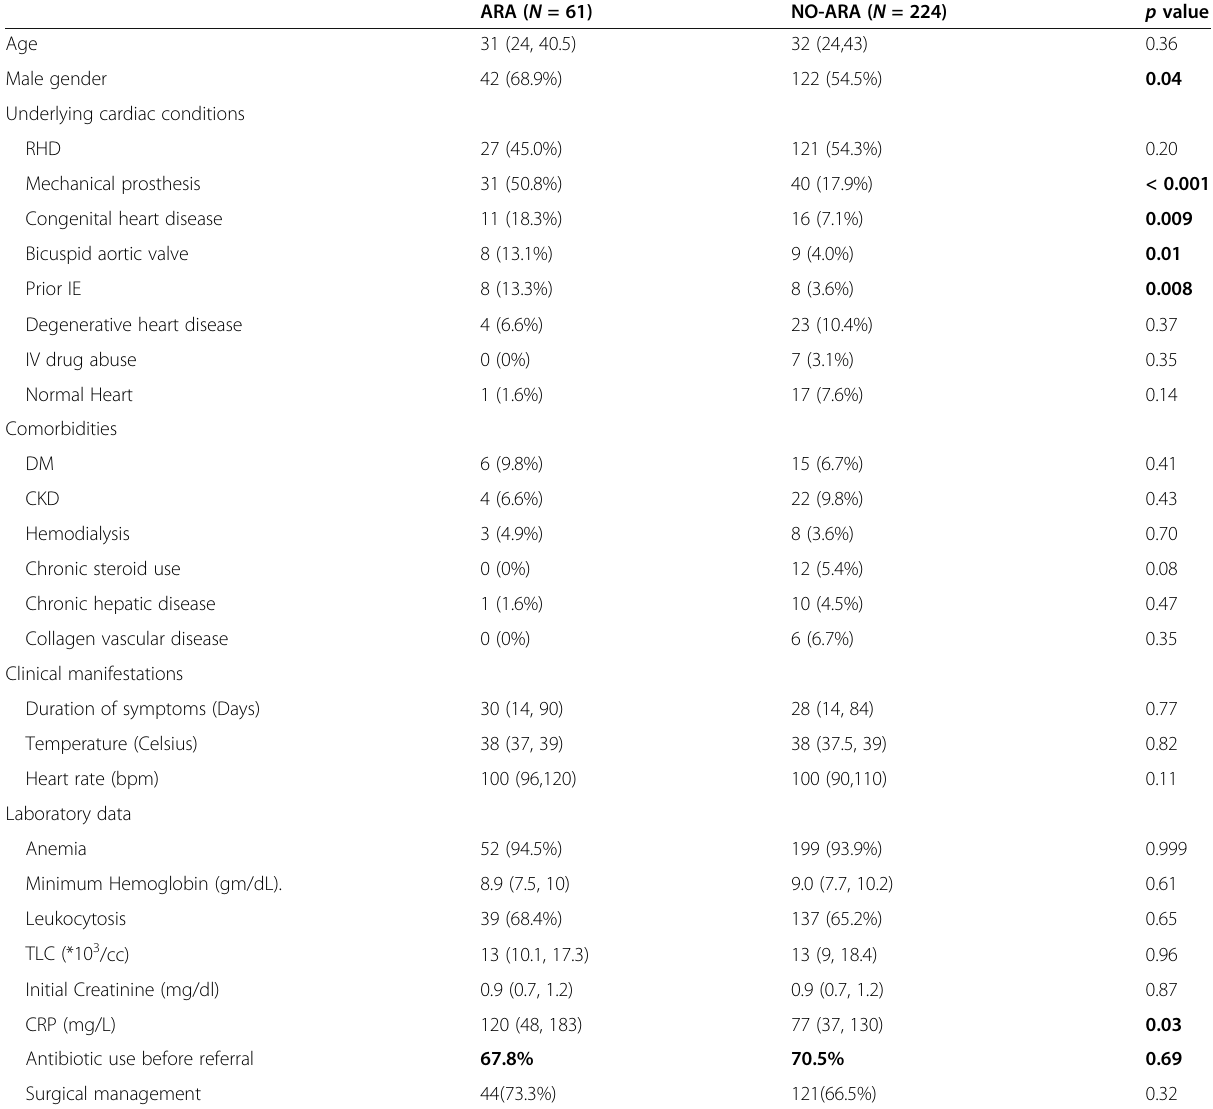
Table 1 Demographic, clinical characteristics, and laboratory data of the patients with and without aortic root abscess, median ± IQR or N (%)